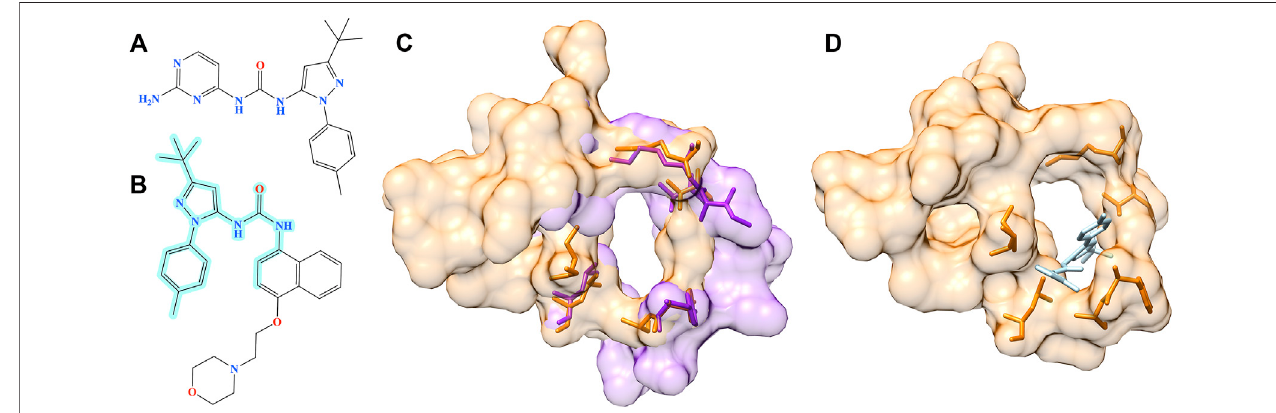
FIGURE10| ExampleoftheevaluationbypocketalignmentforabindingsiteinTie-2. (A) AmoleculegeneratedbyPocket2Drugatrank9. (B) Asimilarcompound, doramapimod,withthemaximumcommonsubstructuretoPocket2Drugmoleculehighlightedincyan. (C) AstructurealignmentbetweenthetargetbindingsiteinTie-2 (orange) and doramapimod binding pocket in EphA2 (purple). (D) The molecule generated by Pocket2Drug (ice blue) docked to the target site in Tie-2 (orange) with